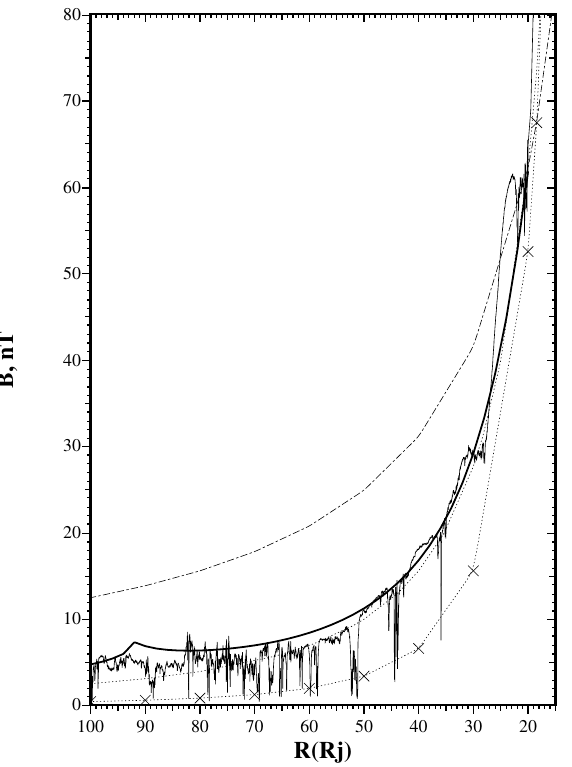
Fig. 4. Noon–midnight meridional cross section. The magnetic field lines of the Jovian tail current system are shown. The magnetic field Fig. 4. Noon(cid:150)midnight meridional cross-section. The magnetic (cid:2)eld lines of the jovian tail current points north at the dayside equator. The chosen values of the model parameters R ss , R 2 , and B t are 100 R J , 65 R J , and − 0.5nT, respectively. system are shown. The magnetic (cid:2)eld points north at the dayside equator. The chosen values of 0 . 5 nT, respectively. the model parameters R ss , R 2 , and B t are 100 R J , 65 R J , and (cid:0)